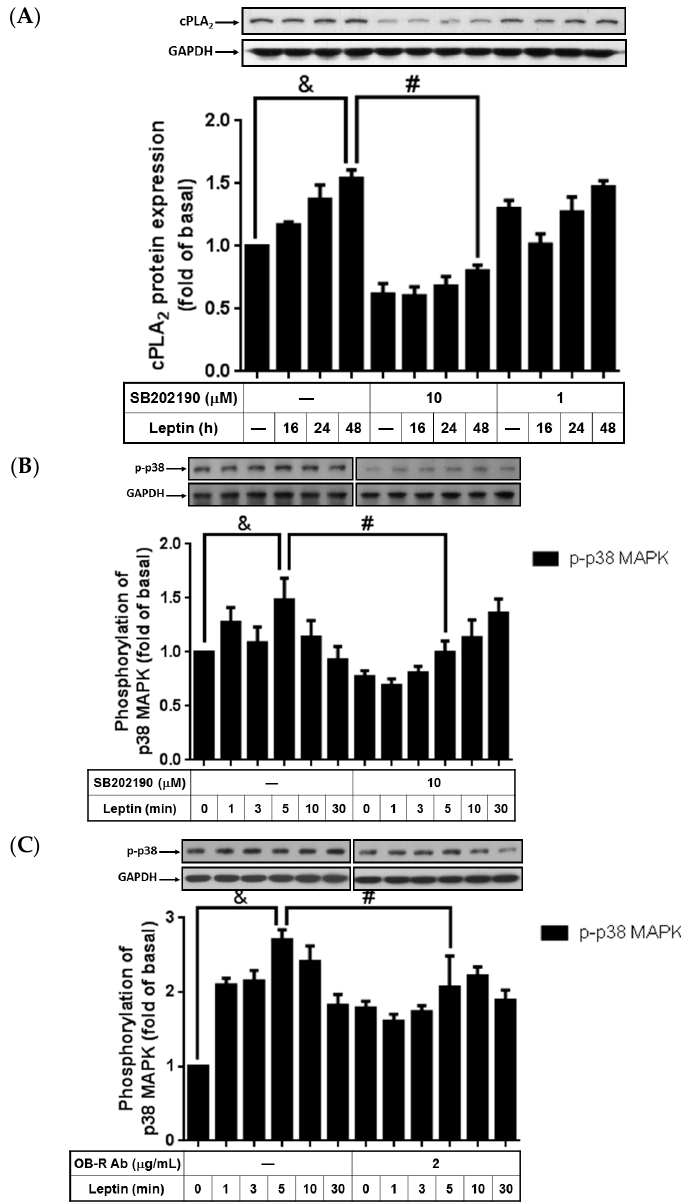
Figure 3. SB202190 attenuation of cPLA 2 - α expression and p38 MAPK phosphorylation. Serum-starved A549 cells were pretreated with different concentrations of SB202190 or the OB-R antibody for 1 h and then stimulated by 1 µg/mL of leptin for the indicated time intervals. At the end of incubation, the cells were harvested and cell lysates were extracted. ( A ) Expression of cPLA 2 - α and ( B , C ) phosphorylation of p38 MAPK were detected using Western blot with specific antibodies. Cell membranes were stripped and reprobed with the anti-GAPDH antibody as internal controls. The data are expressed as mean ± SEM of five independent experiments ( n = 5). & p < 0.05 as compared with the cells exposed to the vehicle alone; # p < 0.01 as compared with the cells exposed to leptin.